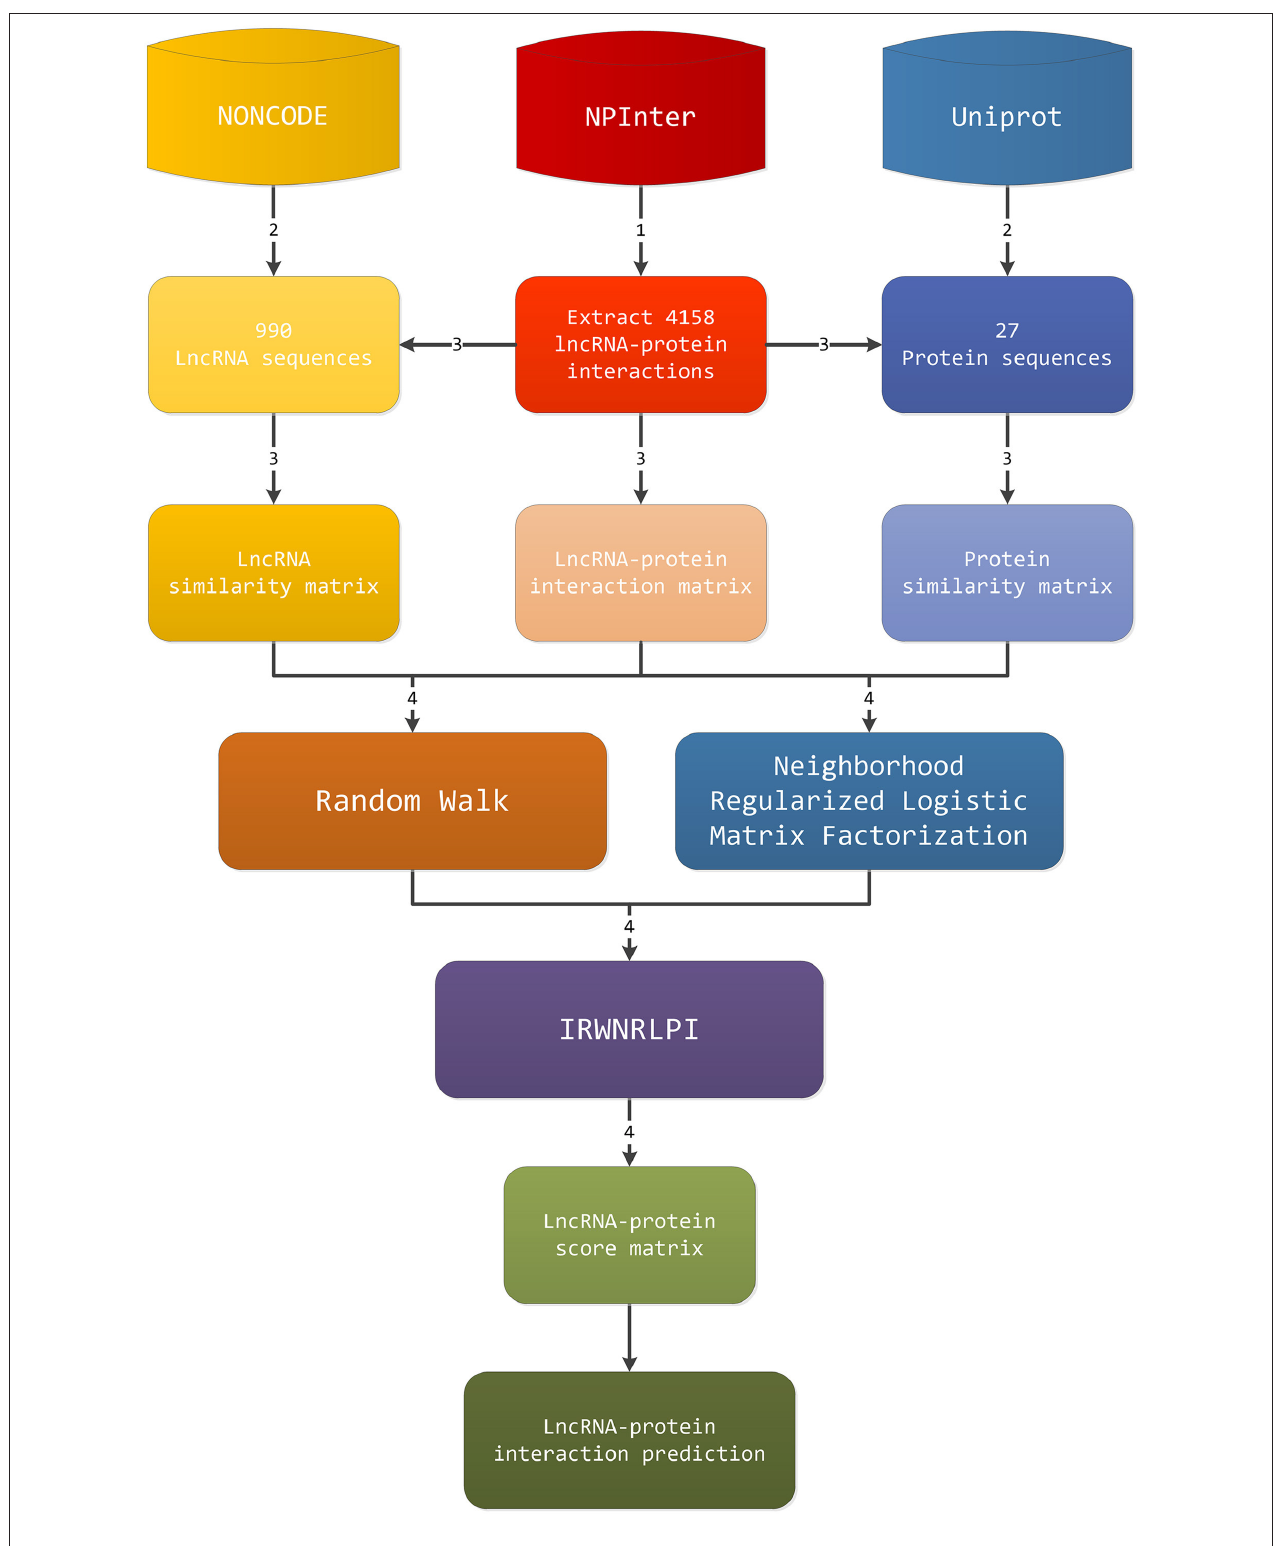
FIGURE 1 | The work flow of the IRWNRLPI